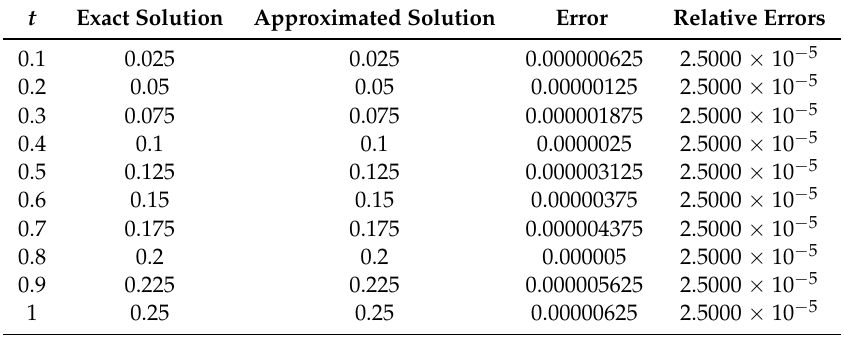
Table 4. Comparing Approximated and second component of exact Solutions with